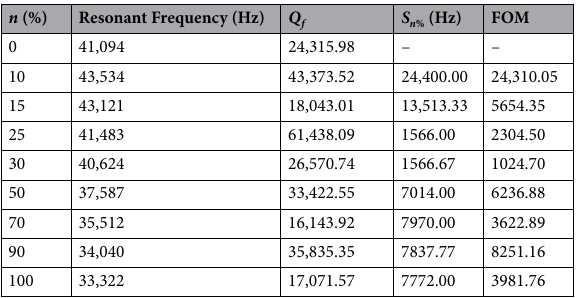
Table 3. Performance parameters of PnC sensor when sensing 10–100% acetone concentration.